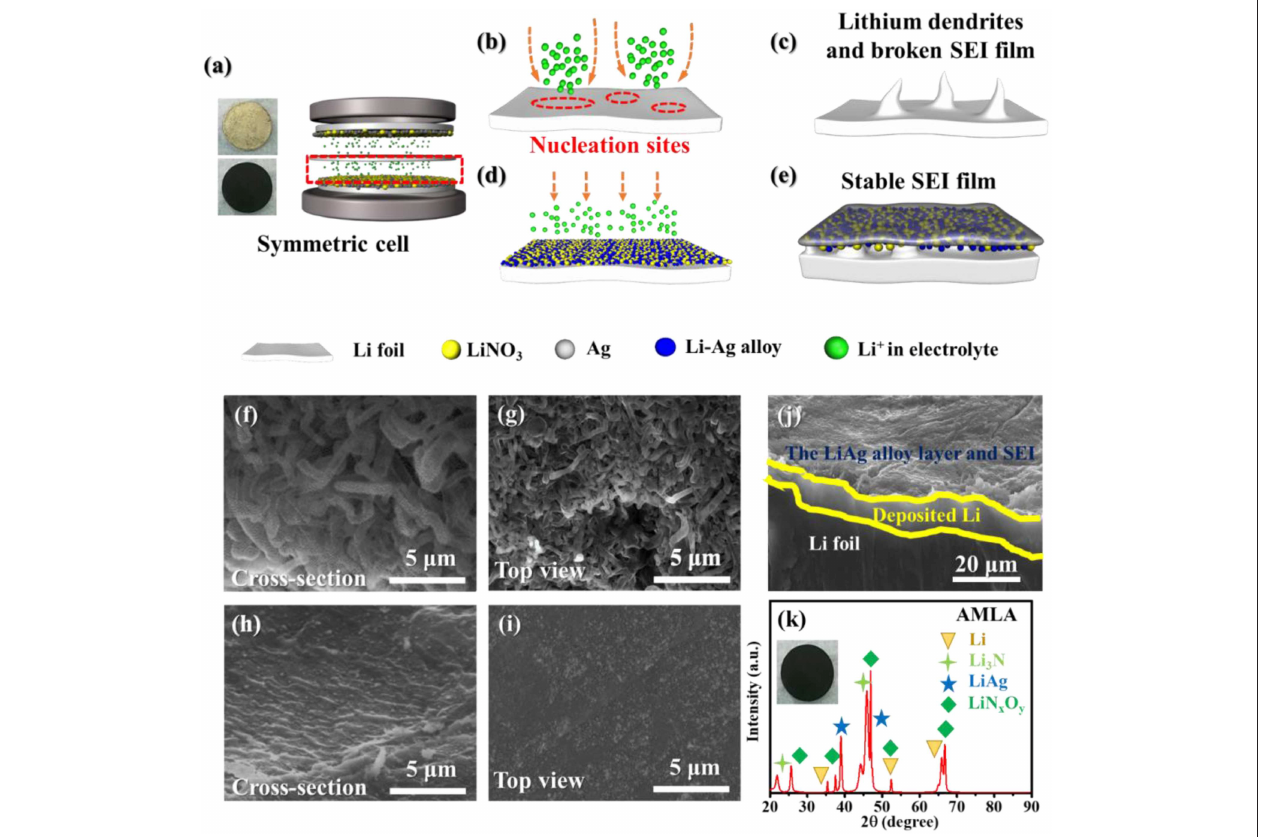
FIGURE 4 | The change of anode when during charge/discharge progress and the morphology of Li anode and AMLA. (a) The schematic of symmetric cell. (b,c) The schematic of change on Li anode during charge/discharge progress. (d,e) The schematic of change on AMLA during charge/discharge progress. (f,g) SEM images of cross-section and top-view of Li anode after cycles. (h,i) SEM images of cross-section (h) and top-view (i) of AMLA after cycles. (j) SEM images of cross-section AMLA with the deposit amount of 1 mAh cm − 2 as the current density of 1mA cm − 2 . The XRD curves of AMLA (k)